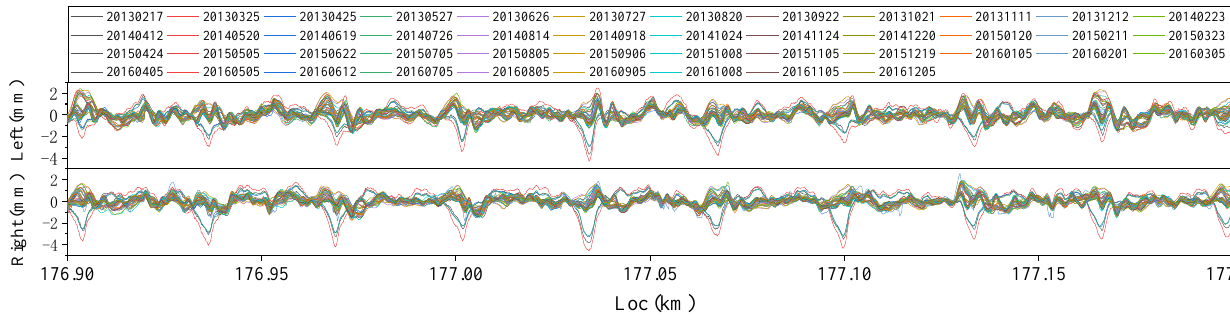
Figure 26. Curve of track longitudinal level of a HSR line.